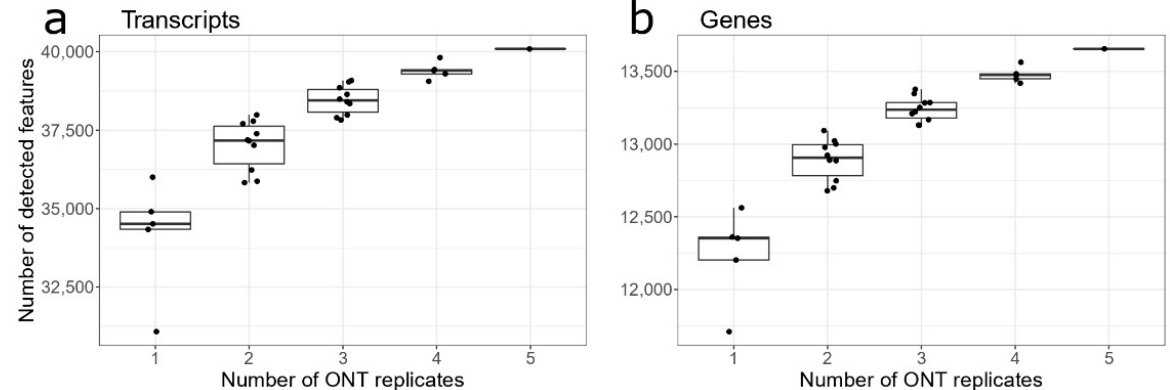
Figure 3. Total number of detected features for various number of replicates. Different combinations of experimental replicates ONT-1, . . . , ONT-5 were generated. Each transcript ( a ) or gene ( b ) was claimed to be expressed if it was detected in at least one replicate included in the combina ‐ tion.